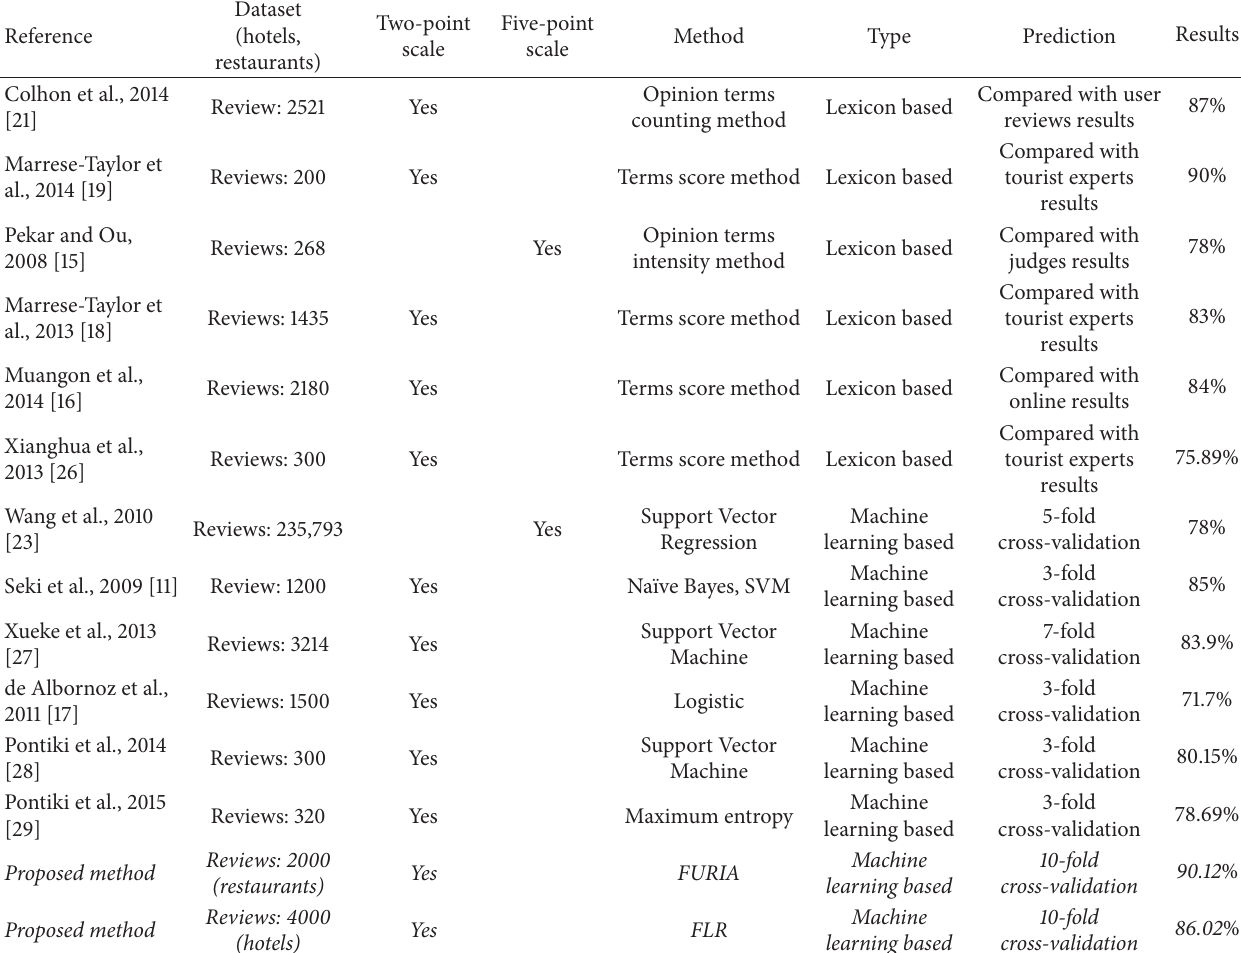
Table 2: Critical evaluation of aspects based classification